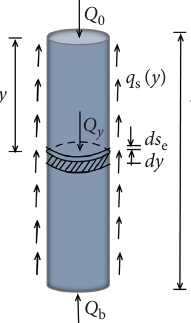
Figure 9: Calculation model of pile